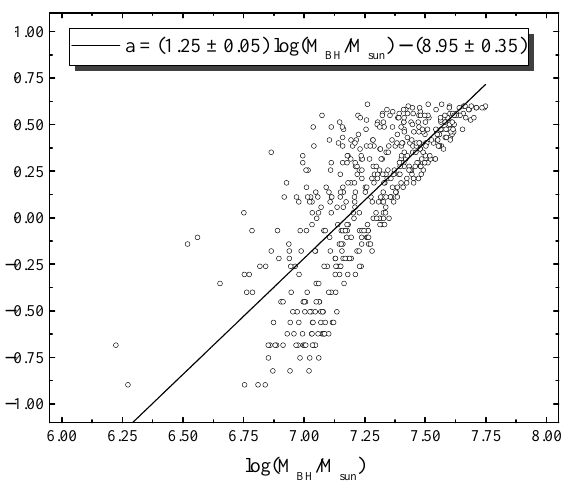
Figure 11. The dependence of the estimated spin values a on the SMBHs masses M BH